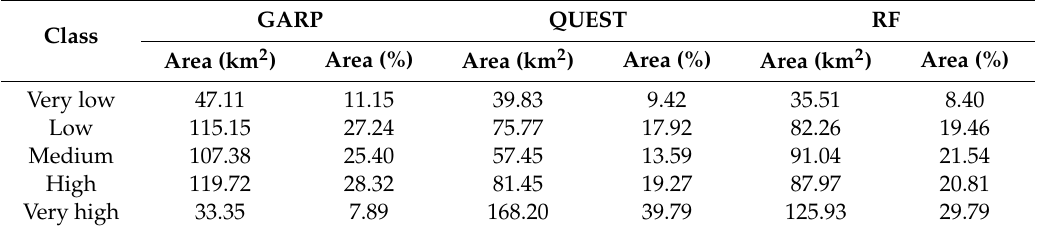
Table 3. Watershed area occupied by five groundwater potential classes according to the GARP, QUEST, and RF models.